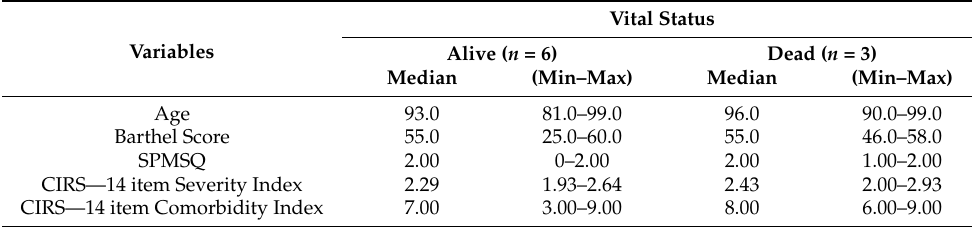
Table 5. Characteristics of the BNT162b2-vaccinated guests testing positive for SARS-CoV-2 stratified by vital status.